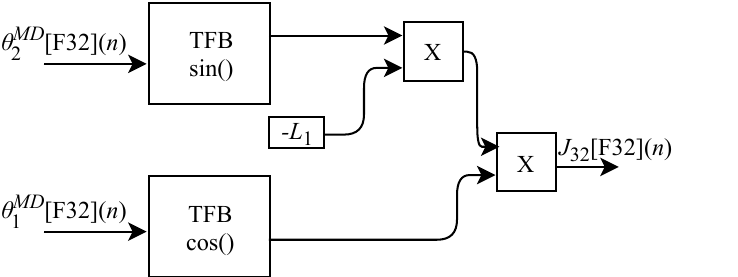
Figure 22. Proposed circuit to calculate the Jacobian matrix J 32 [ F 32 ]( n ) (Equation (34))—JM.